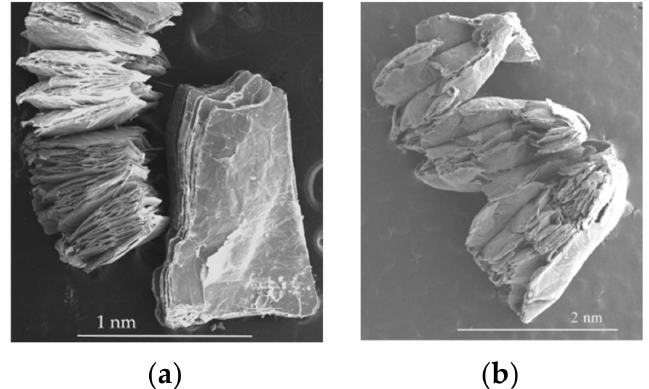
Figure 1. Exfoliated vermiculites: ( a ) abruptly at 1000 ◦ C, CHGE-H sample and ( b ) microwave irradiation, CHGE-MW.